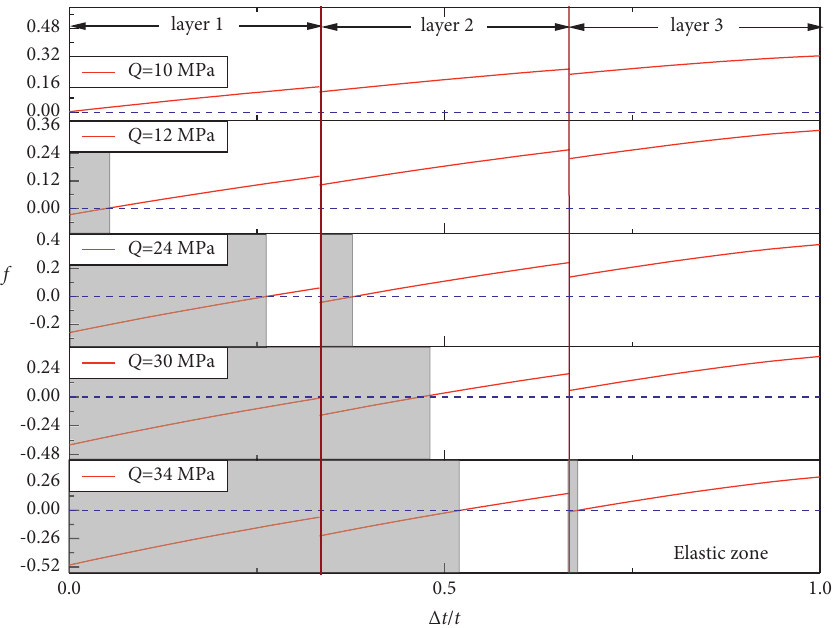
Figure 9: The failure mode of 3-layer FGL under horizontal confining pressure.